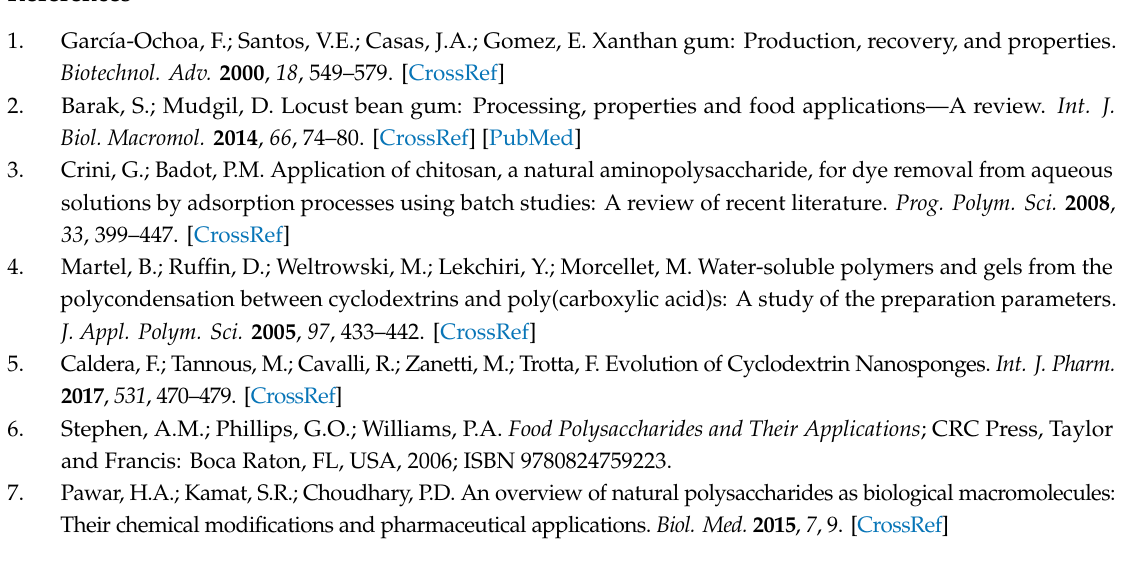
Table S2: RGB color parameters of samples. Table S3: Calculation of unreacted cyclodextrin by size exclusion chromatography. Figure S1: Yield of soluble and insoluble products of the crosslinking reaction prepared using di ff erent feed ratios. Figure S2: Yields of insoluble fractions of networks crosslinked using di ff erent catalysts. Figure S3: FTIR spectra of crosslinking products using di ff erent catalysts and di ff erent ratios of disodium phosphate. Figure S4 (a–f): Infrared spectra of the saponification residues of the resins crosslinked at di ff erent times and temperatures. Table S4: Swelling degrees in water, acetone and 1-octanol. Figure S5: Sorption of 1-naphthol in polysaccharides. Figure S6: Total absorption and release kinetics of methylene blue and methyl orange. Table S5: Curve fitting results for kinetic measurements. Table S6: Amount of methylene blue and methyl orange (% mass) absorbed. Figure S7: SEC results of soluble fractions obtained from LBG / CD and CS / CD. Table S7: Hydrodynamic radii of soluble crosslinked samples. Figure S8: Infrared spectra for the citrate-crosslinked soluble and insoluble networks. Fluorescence quenching investigation for the soluble polysaccharides. Table S8: Interaction constants with 1-naphthol, obtained from fluorescence emission spectra. Figure S9: Fluorescence ratios as a function of the polysaccharide